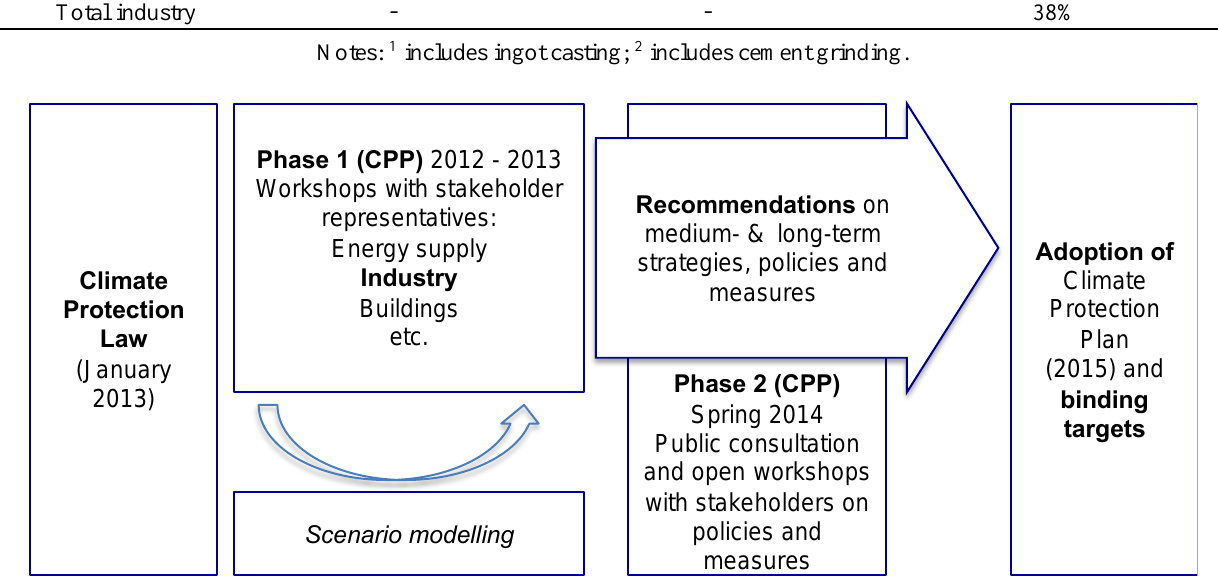
Figure 1. Representation of the process leading up to the NRW Climate Protection Plan, including iterative cycle of stakeholder discussions and quantitative scenario